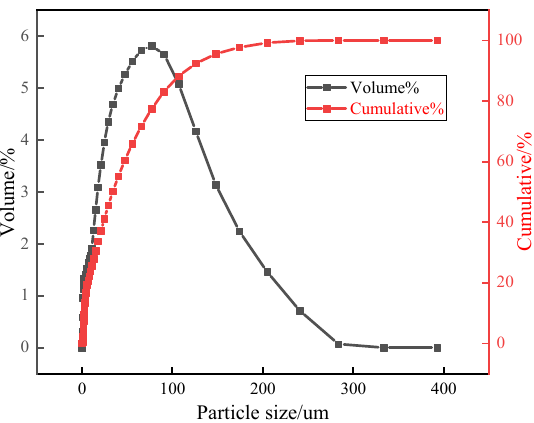
Figure 1. Laser particle size analysis of the zinc-bearing dust sludge.